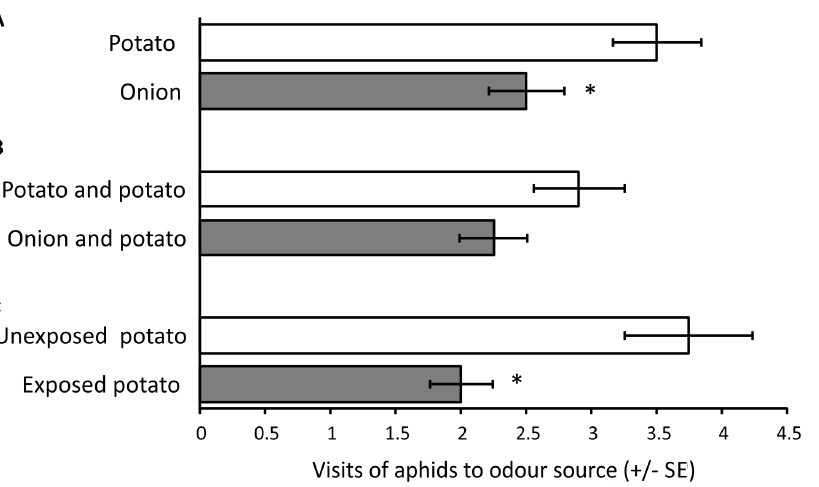
Figure 2. Aphid olfactory responses to volatiles from living plants. Behavioural responses of winged Myzus persicae in olfactometer experiments when offered choice between (A) volatiles of onion tested and volatiles of potato, (B) volatile mix of onion and potato and volatile mix of two potato plants, and (C) volatiles of onion-exposed potato and volatiles of unexposed potato plants. Asterisks indicate significant preferences * P # 0. 05, Wilcoxon matched pairs test.